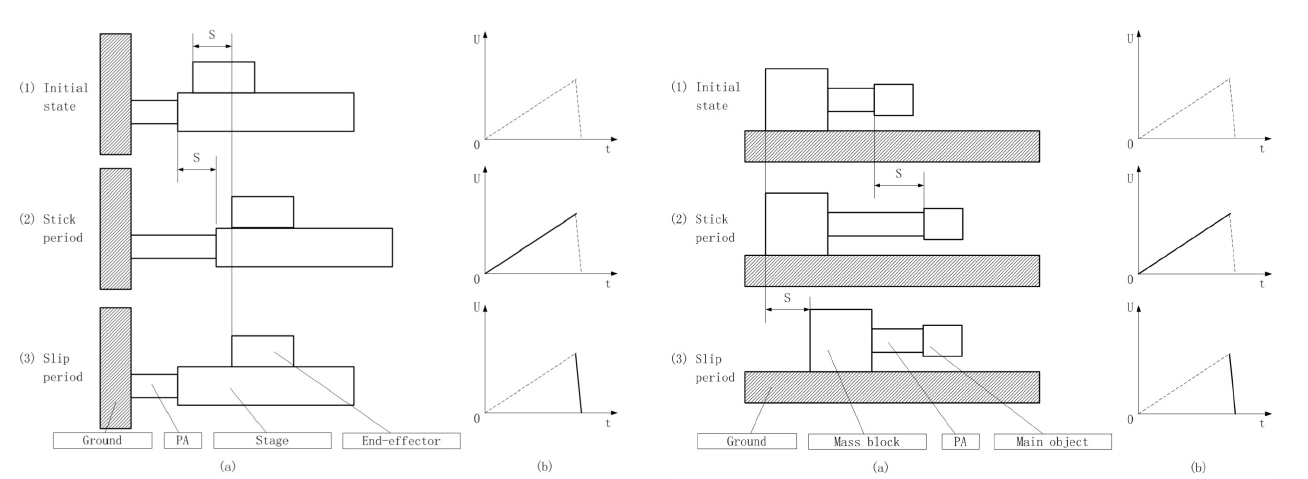
Figure 2. The principle of the IDM: (a) actuation steps and (b) in- put